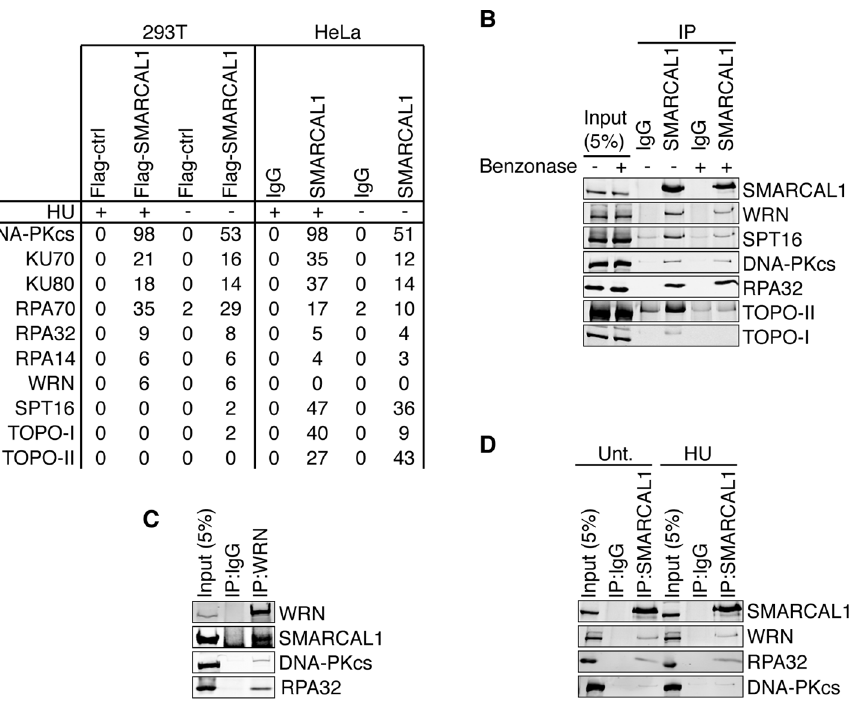
Figure 1. Identification of SMARCAL1 interacting proteins by mass spectrometry. (A) 293T cells were transfected with a Flag-SMARCAL1 expression vector or an empty vector control. Cells were harvested, lysed and Flag antibody conjugated beads were used to immunopurify SMARCAL1. HeLa cells expressing endogenous SMARCAL1 were harvested, lysed, and SMARCAL1-909 antibody or IgG control antibody were used for immunopurification. Proteins were eluted from beads with either the Flag or SMARCAL1-909 peptides and subjected to 2D-LC-tandem mass spectrometry. Where indicated, the cells were treated with 2 mM HU for 16 h prior to harvesting. The number of peptides identified in each purification is reported. (B–D) HeLa nuclear extracts were prepared. Control IgG, SMARCAL1-909 antibody, or WRN antibody immunoprecipitates (IP) as indicated were separated by SDS-PAGE and immunoblotted with the indicated antibodies. Where indicated the nuclear extracts were treated with benzonase prior to the immunoprecipitation. In (D) the cells were either mock treated (Unt.) or incubated with 2 mM HU for 16 h prior to harvesting.